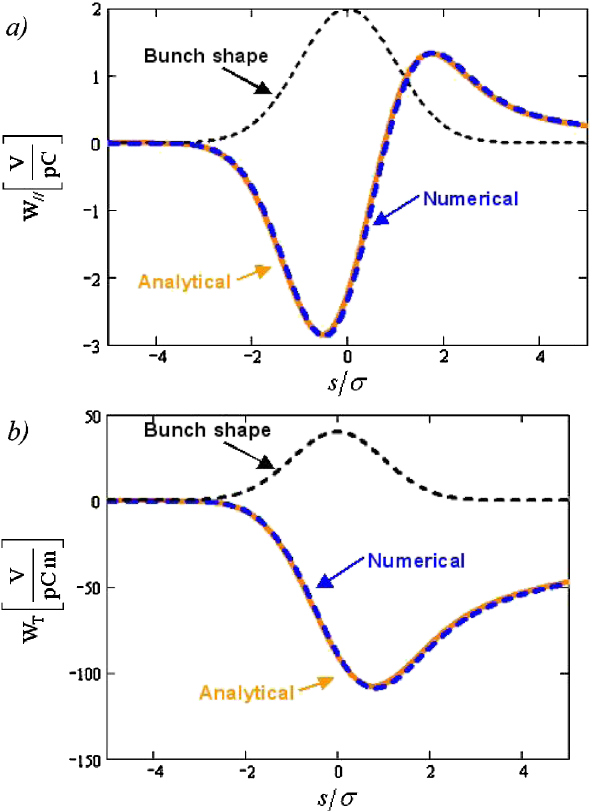
FIG. 10. Comparison of the numerical longitudinal monopole and transverse dipole wake potentials (blue dashed) with ana- lytical solutions (orange solid).